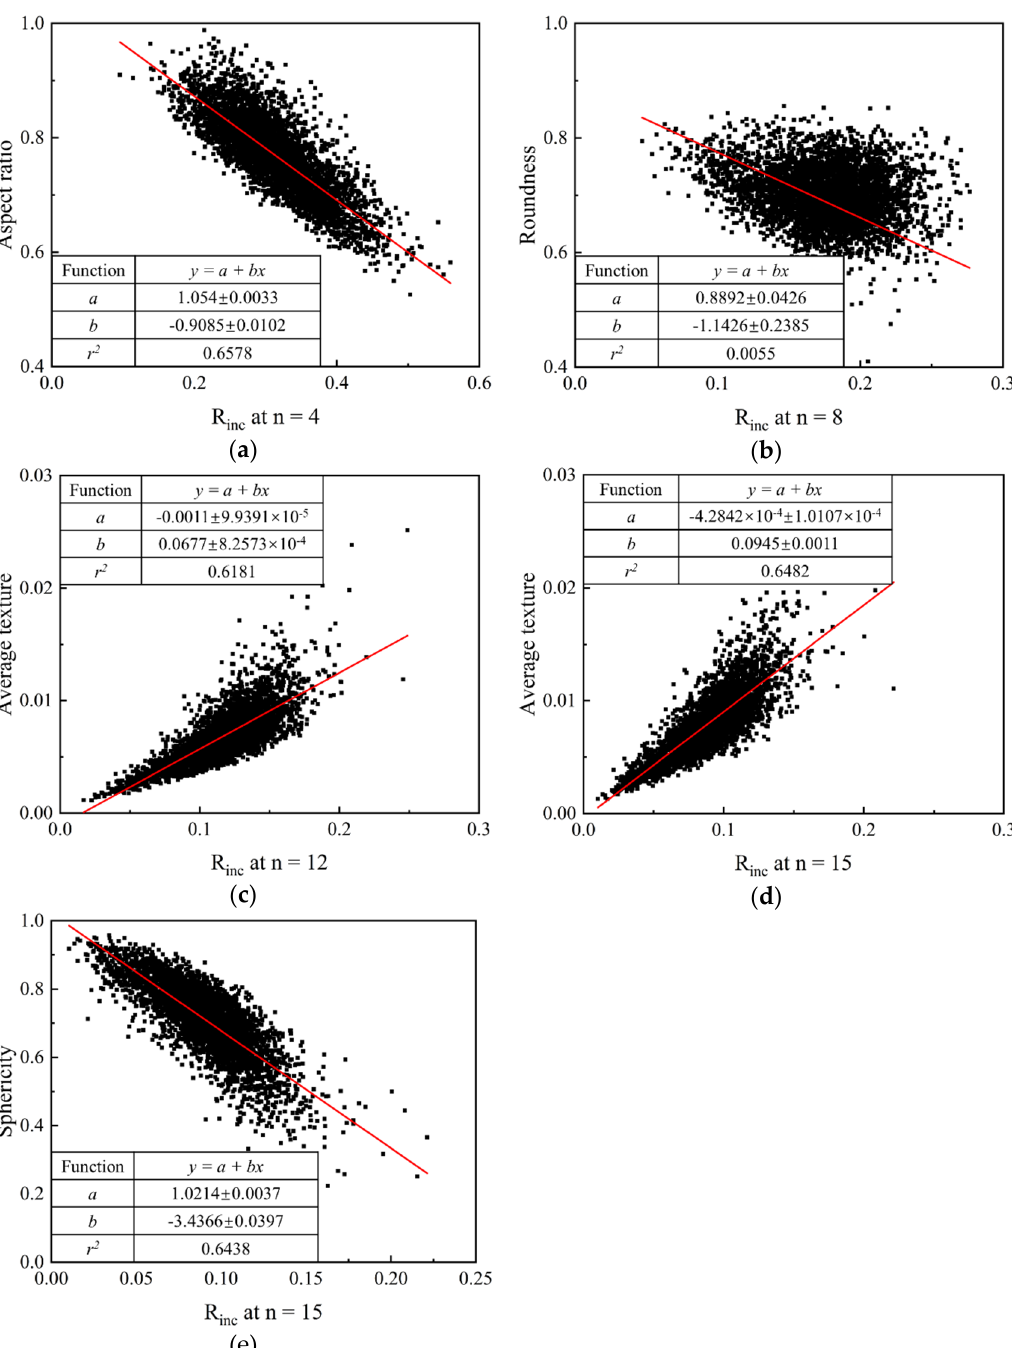
Figure 9. Relationship of R inc and traditional descriptors at target RLS: ( a ) aspect ratio; ( b ) roundness; ( c ) average texture of 1L-ST; ( d ) average texture of 2L-ST; ( e ) sphericity.